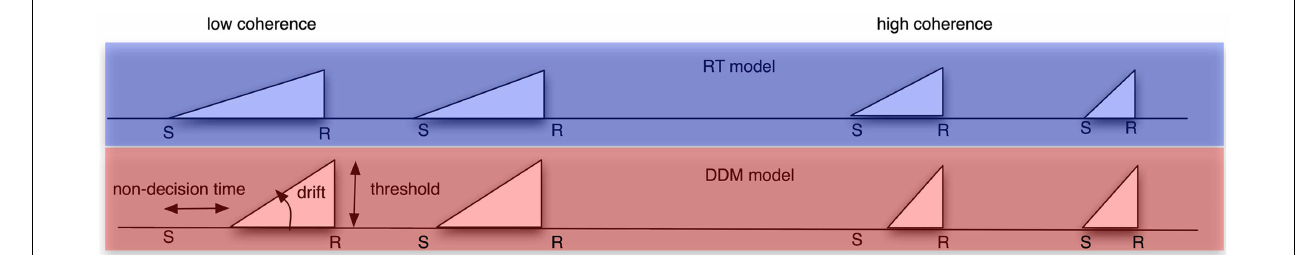
FIGURE 2 | Schematic of the different models we used to create regressors from. Top row: RT model. Bottom row: DDM model. Left column: low-coherence condition. Right column: high-coherence condition. In the RT model, the ramp always starts at stimulus onset and ends always at the response, and it always has a height of one. It therefore has a different length for the slower and faster trials within a